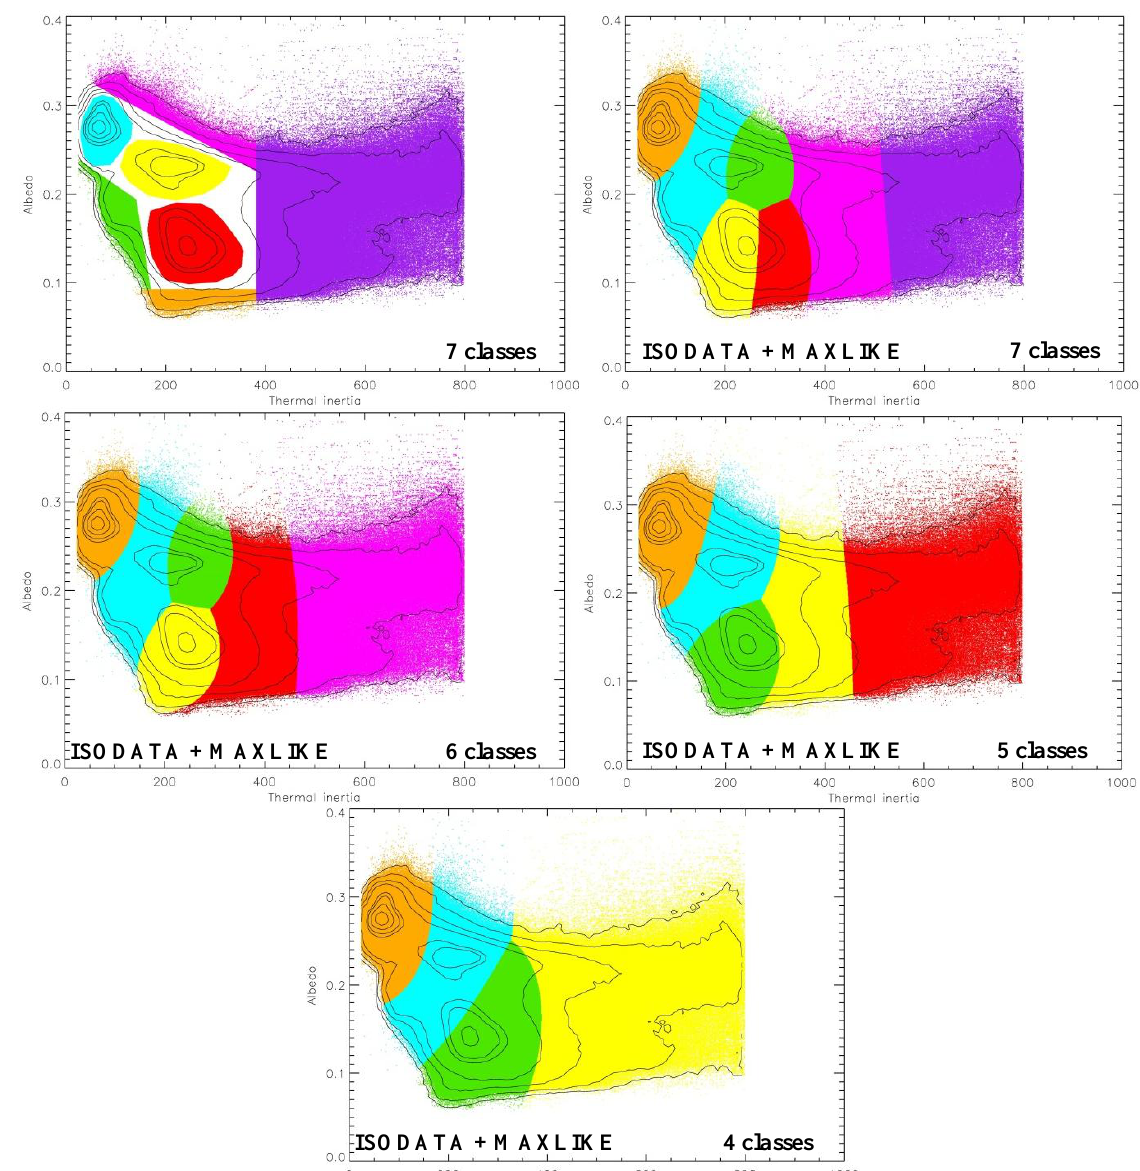
Figure 14. Comparison between the manual classification of [8] and an algorithmic classification by ISODATA and Maximum Likelihood on the same older 2005 datasets of albedo and thermal